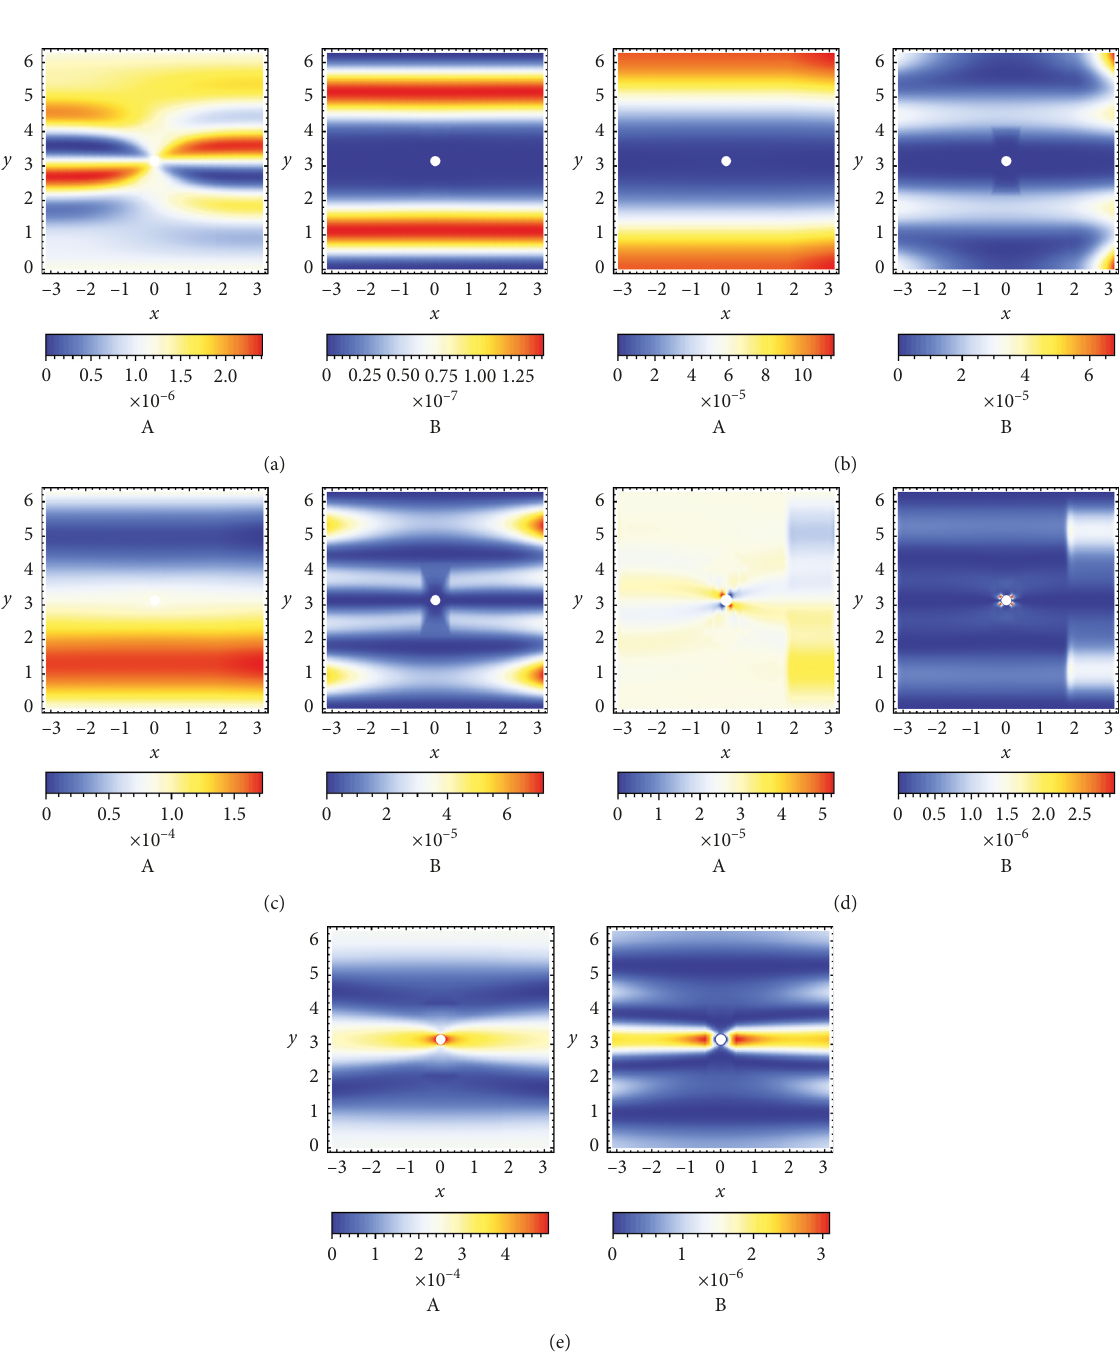
Figure 7: Short cylinder with junctions: expected value and variance of the first eigenmode. Solution computed with p � 3 and L � 2 (45 collocation points). (a) Expected value (A) and variance (B) of the component μ . (b) Expected value (A) and variance (B) of the component v . (c) Expected value (A) and variance (B) of the component w . (d) Expected value (A) and variance (B) of the component θ . (e) Expected value (A) and variance (B) of the component ψ